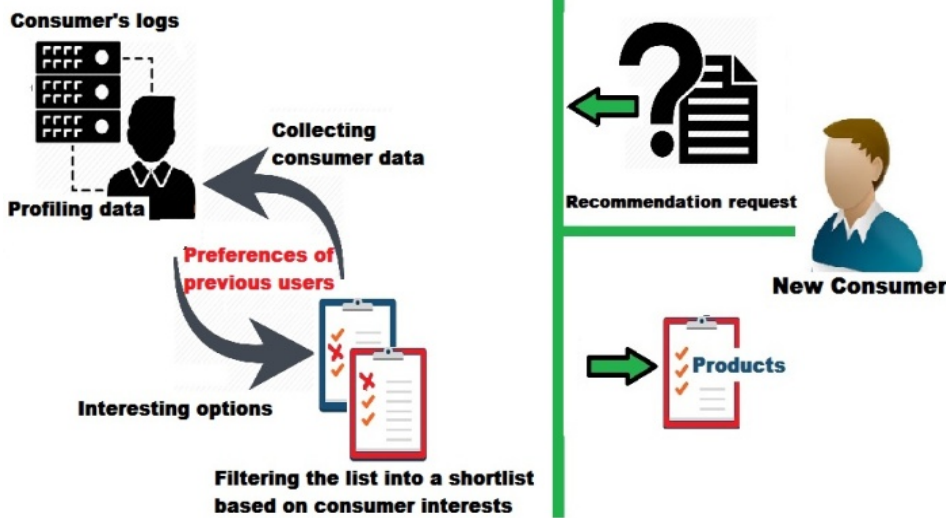
Figure 6. Filtering based on consumer’s interests.